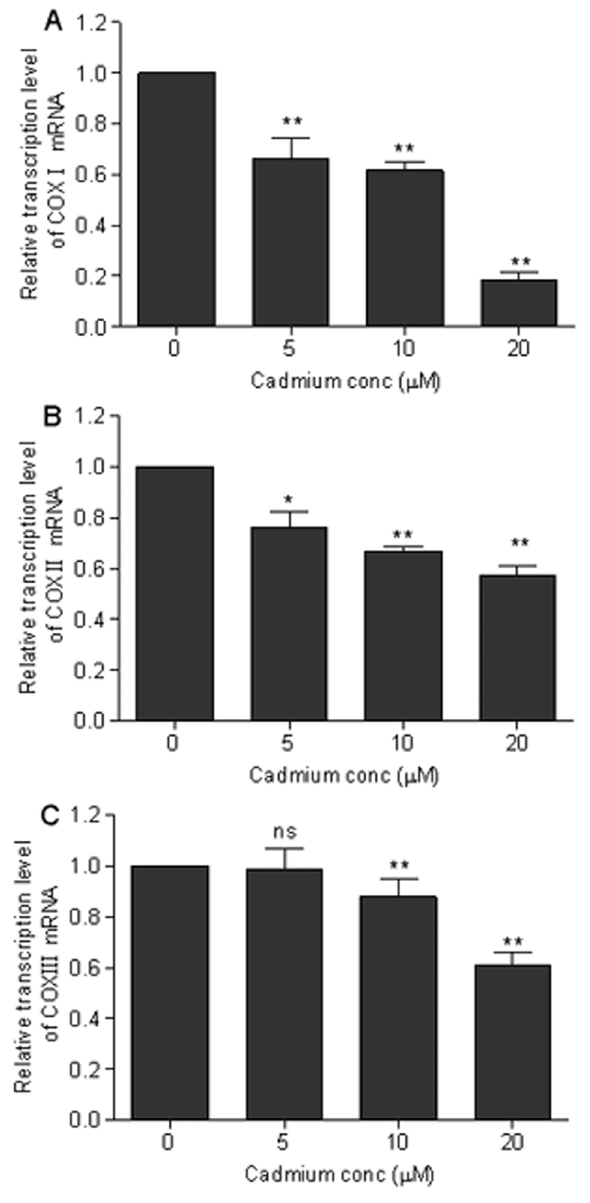
Figure 4. Relative transcription levels of the genes in neurons exposed to Cd for 6 h. The transcription levels were calculated relative to the control group, whose expression level was set to one. (A) Cytochrome oxidase subunit I (COX-I). (B) Cytochrome oxidase subunit